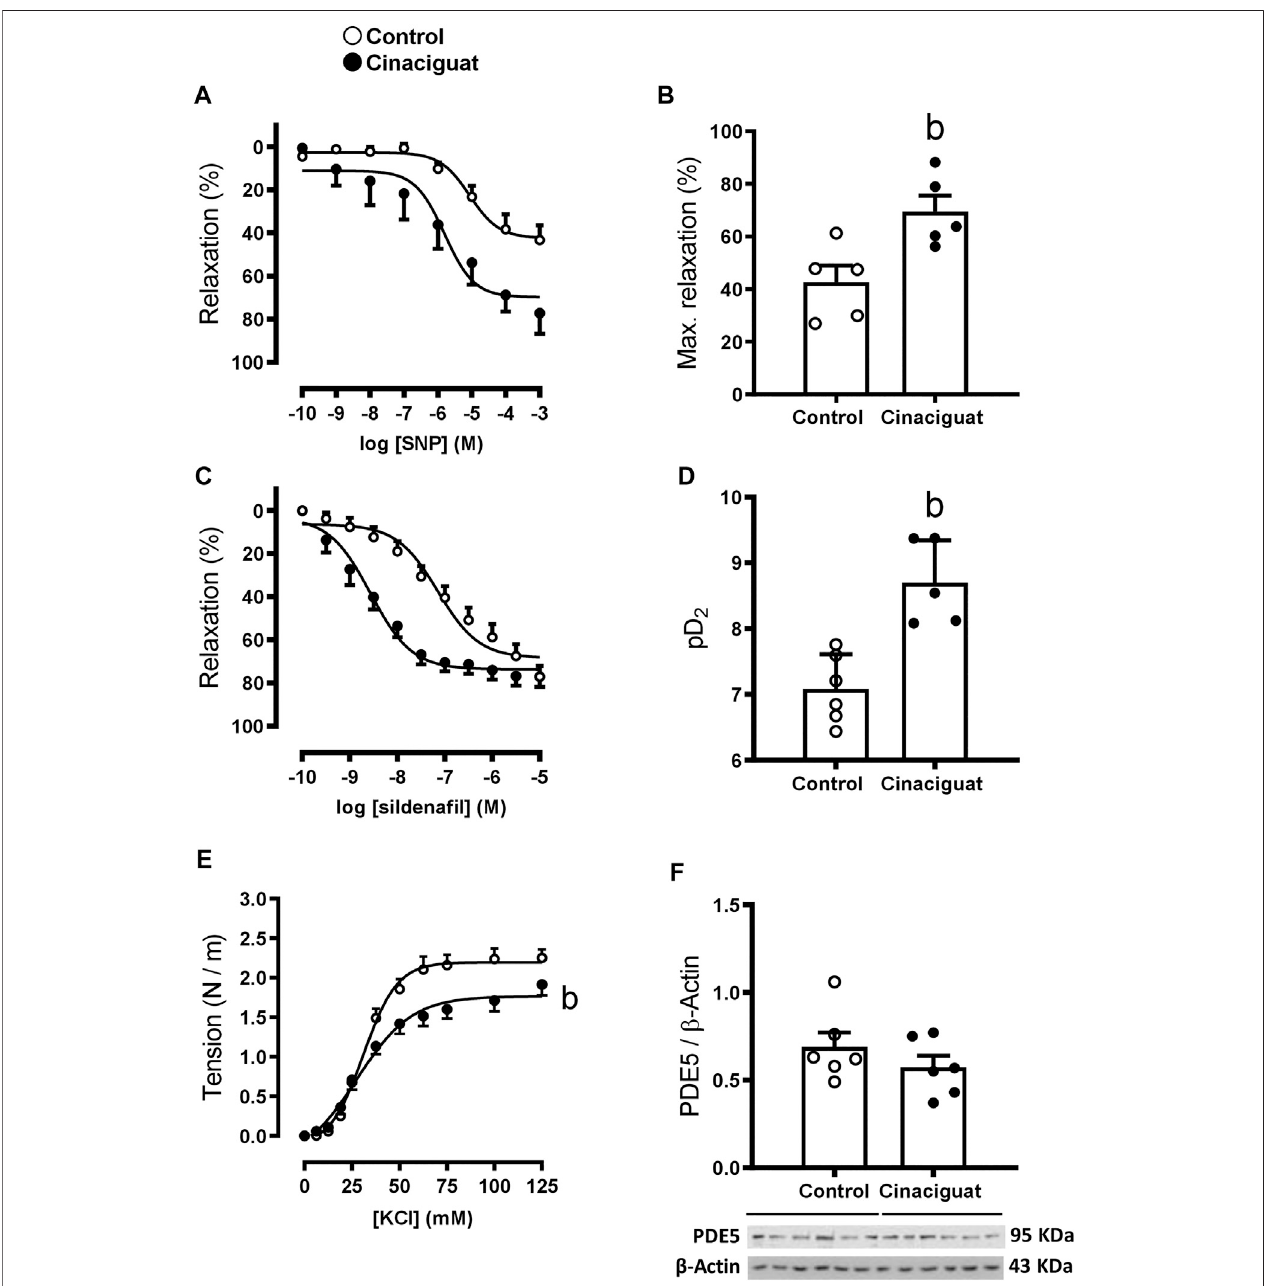
FIGURE9| Effect ofCinaciguattreatment onthevasodilatorandvasoconstrictorfunctioninisolatedsmallpulmonary arteriesandlungproteinexpression ofPDE5 inchronicallyhypoxicandpulmonaryhypertensiveneonatallamb.ResponsestoSNPandsildena fi lofsmallpulmonaryarteries.Y-axis,percentrelaxation(%);X-axis,log SNP and sildena fi l molar concentration (M) [ (A,C) , respectively]. Histograms show maximal relaxation (%) and sensitivity (pD2) [ (B,D) , respectively]. Responses to KCl, Y-axis tension (N/m), X-axis KCl concentration (mM) (E) . Western Blot of PDE5/ β -Actin (F) . The β -Actin image was re-used for illustrative purposes. For SNP experiments, Control (Open circles, n = 5) and Cinaciguat-treated lambs (Black circles, n = 5). For sildena fi l experiments, Control (Open circles, n = 6) and Cinaciguat- treated lambs (Black circles, n = 5). For KCl experiments, Control (Open circles, n = 6) and Cinaciguat-treated lambs (Black circles, n = 6). For PDE5 WB experiments, Control (Open circles, n = 6) and Cinaciguat-treated lambs (Black circles, n = 6). Values are means ± SEM for all experiments. Signi fi cant difference ( p ≤ 0.05): b vs. Control group.